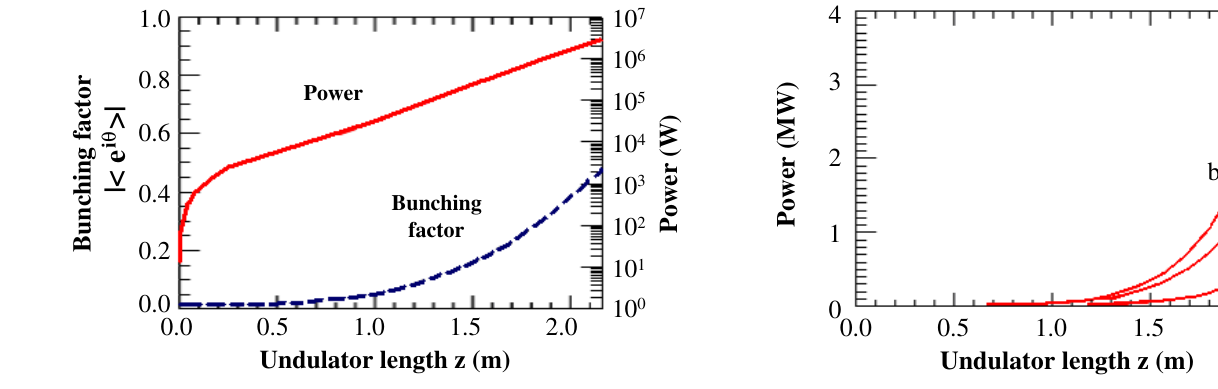
FIG. 11. (Color) Bunching factor and THz power on the third harmonic inside the HGHG radiator after injecting a prebunched electron beam with a peak current of 60 A. The electron beam is prebunched by interacting with a 3 THz pulse with a peak power of 3 MW in a 30 long prebuncher followed by ballistic drifting of 60